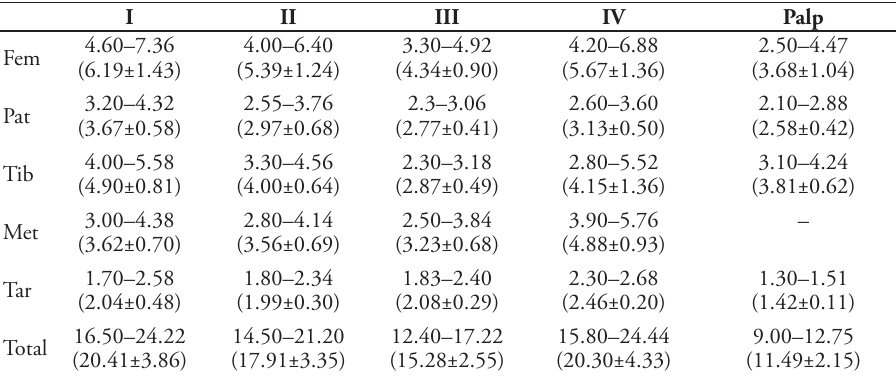
Table 2. Legs and palp measurements of ♂ Phlogiellus longipalpus sp. n. (n= 3) (range, mean ± standard